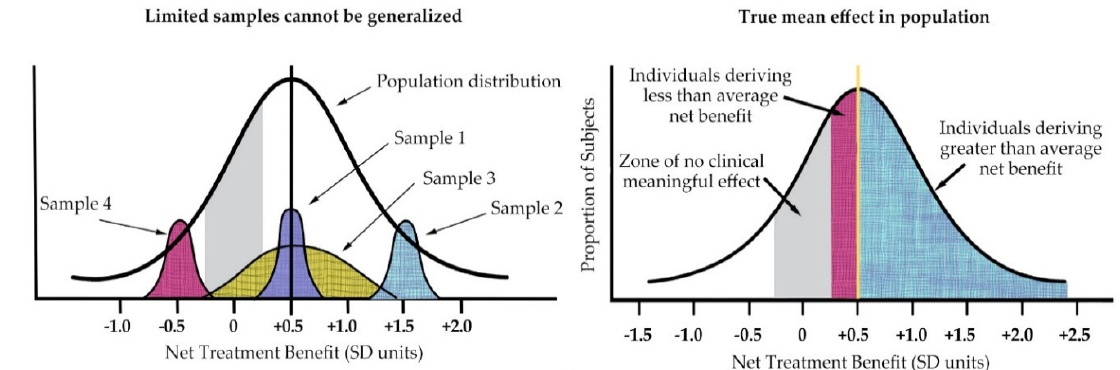
Figure 5. ( left ) Treatment effects of nonrepresentative samples cannot be generalized to the full spectrum of disease; ( right ) In addition, within any given sample, individual patient treatment response varies from mean. (Derived from Kravitz 2004).